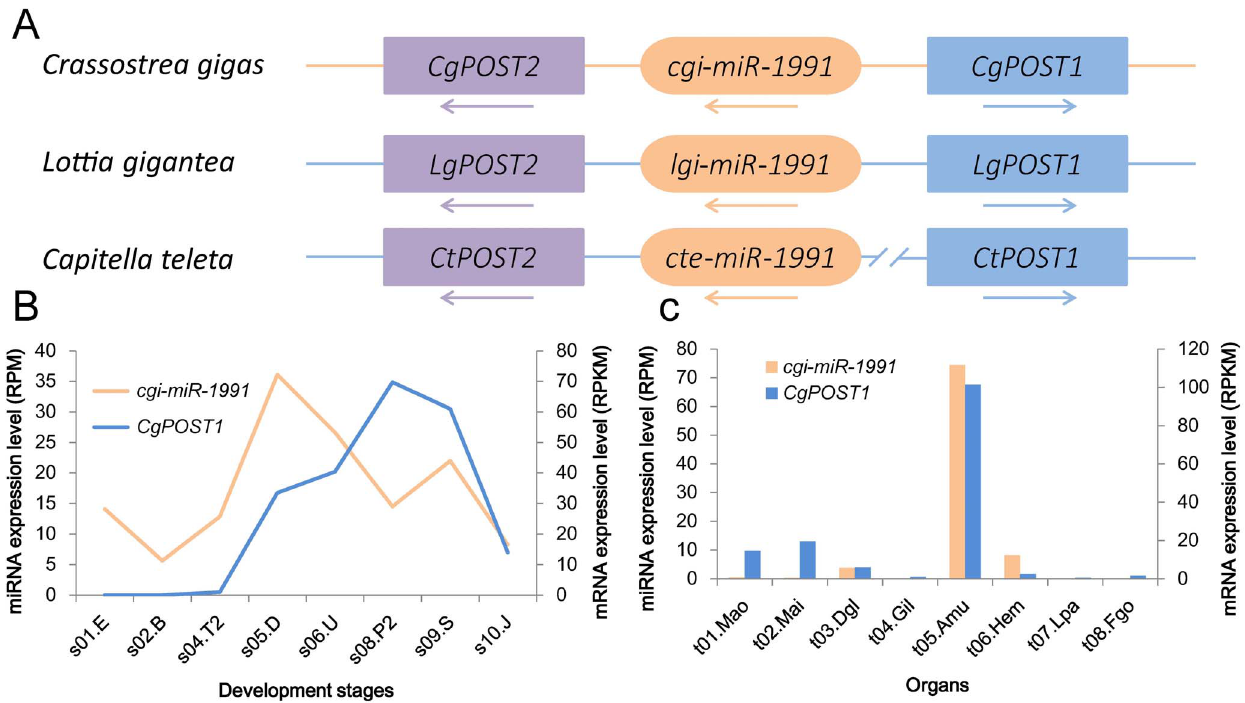
Figure 1. Genomics and expression of mir-1991 and the Post gene cluster. A . Location of the mir-1991 in the Post clusters in Crassostrea gigas , Lottia gigantea and Capitella teleta . Arrow shows the strand orientation of the gene. B . The expression pattern of oyster miRNA cgi-miR-1991 and oyster gene CgPOST1 in different development stages. The samples are abbreviated as follows: s01.E, egg; s02.B, blastula; s04.T2, trochophore; s05.D, D-shape larva; s06.U, umbo larva; s08.P2, pediveliger larva; s09.S, spat; s10.J, juvenile. c. The expression pattern of oyster miRNA cgi-miR-1991 and oyster gene CgPOST1 in different organs. The samples are abbreviated as follows: t01.Mao, outer edge of mantle along the margin of the shell; t02.Mai, inner pallial part covering the inner surface of the shell; t03.Dgl, digestive gland; t04.Gil, Gill; t05.Amu, adductor muscle; t06.Hem, hemolymph; t07.Lpa, labial palps; t08.Fgo, female gonad.